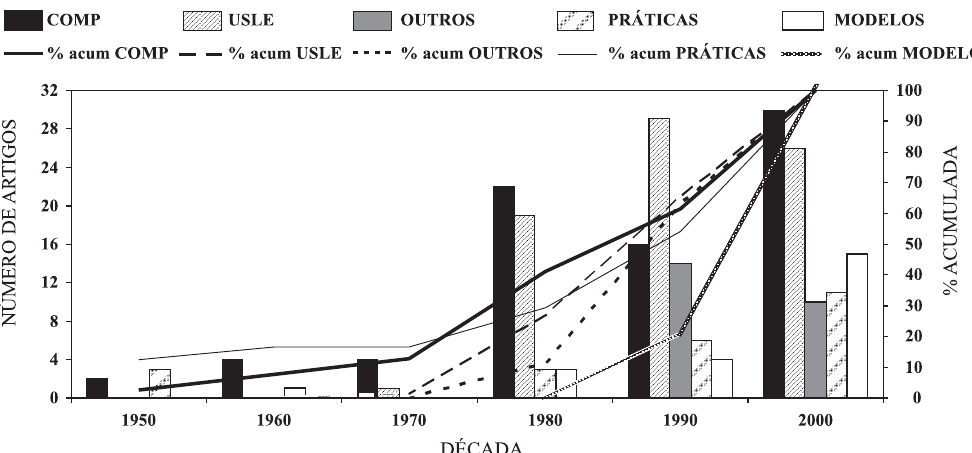
Figura 2. Evolução da quantidade e percentagem acumulada da produção de artigos nas principais linhas temáticas (COMP: comparação de sistemas de manejo; USLE: equação universal de perda do solo; OUTROS: outras abordagens da erosão; PRÁTICAS: análise de técnicas de controle de erosão; MODELOS: outras modelagens e métodos de predição de erosão) relativas à erosão no